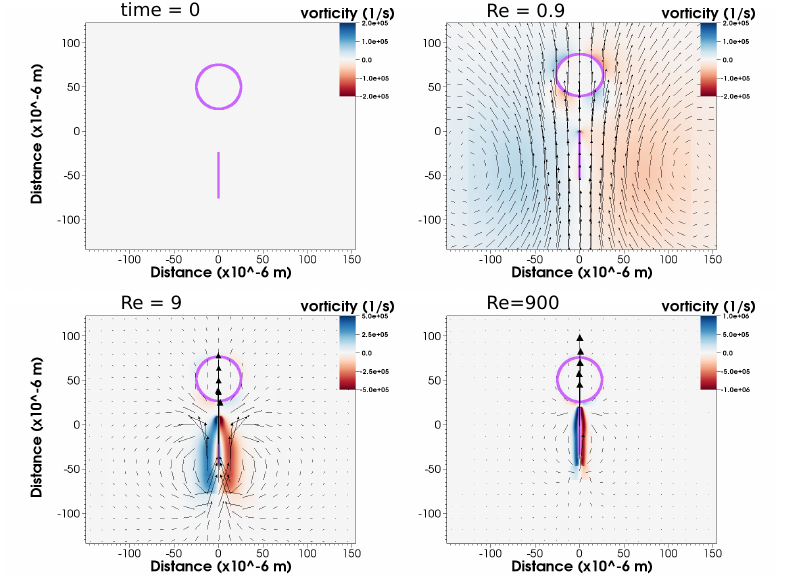
Figure 5. Vorticity, velocity, barb, and prey position at time 5.50 × 10 − 6 s (about 3/4 way through simulation) at the base length and radius for Re = 0.9,9, and 900. The upper left panel shows the initial configuration of the simulation. Note that the prey is untethered and moves with the fluid.